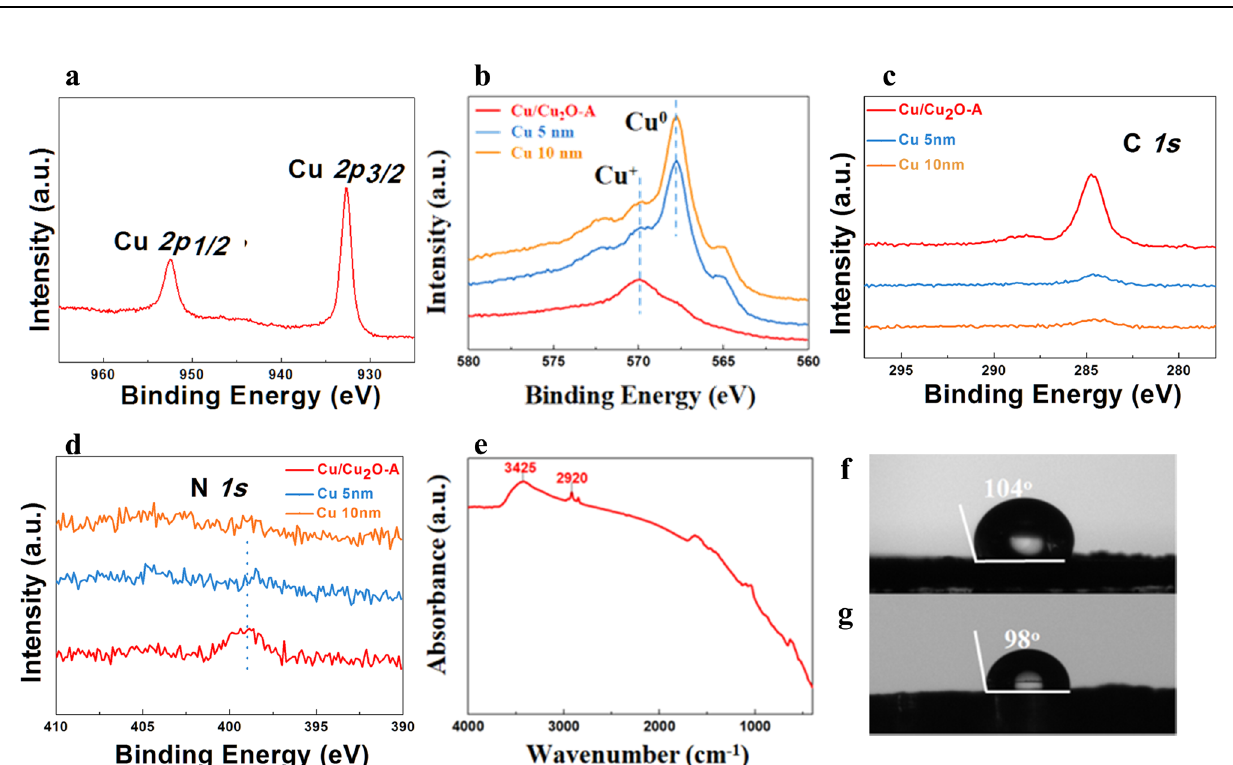
Fig. 3 | Characterization of the Cu/Cu 2 O-A. a Cu 2p XPS spectrum of the as prepared hydrophobic Cu/Cu 2 O-A catalyst. b Cu LMM , c high-resolution C 1s spectra,and d high-resolutionN 1s spectraof Cu/Cu 2 O-A(red),Cu5nm(blue)and Cu 10nm (orange) (Cu 5nm refers to Cu/Cu 2 O-A catalyst etched with 5nm depth;